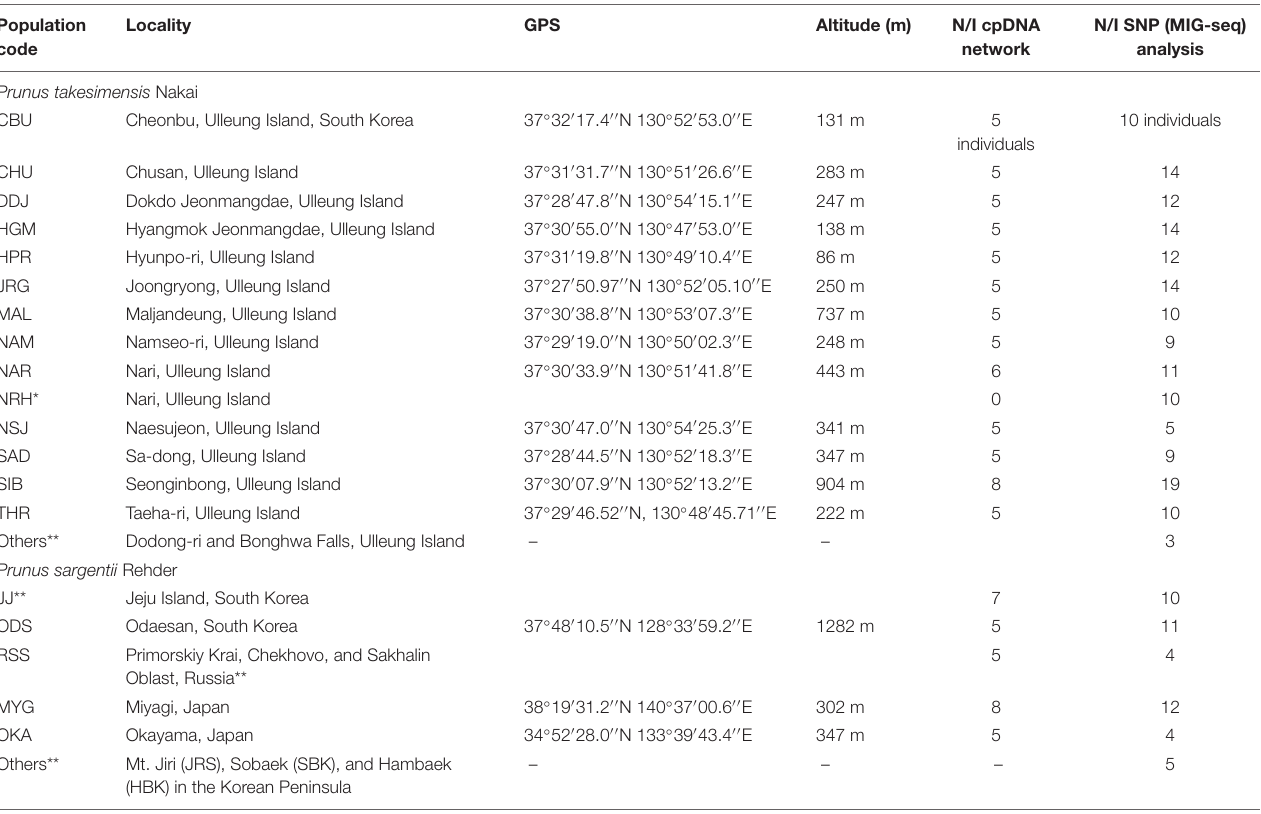
TABLE 1 | List of numbers and sampling locations of P. takesimensis and P. sargentii used for population-level analyses of cpDNA haplotype and MIG-seq SNPs performed in this study. Population Locality GPS Altitude (m) N/I cpDNA code